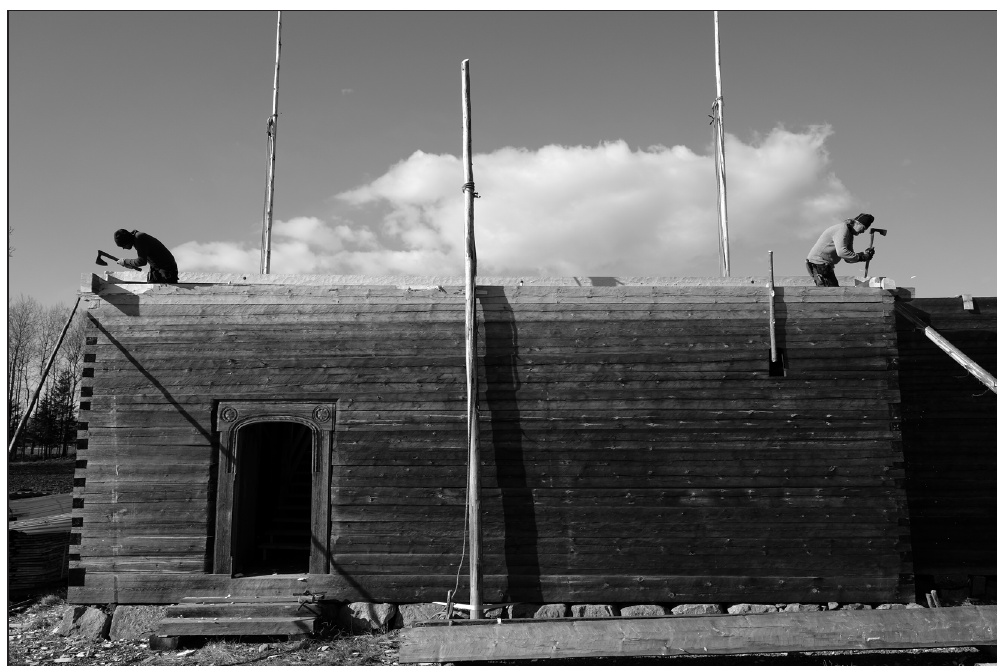
Figure 1: The reconstruction of the medieval timber church of Södra Råda, by using traditional methods and hand tools, primarily aims at a deeper understanding of the original church and its medieval context. (Photo: Gunnar Almevik,